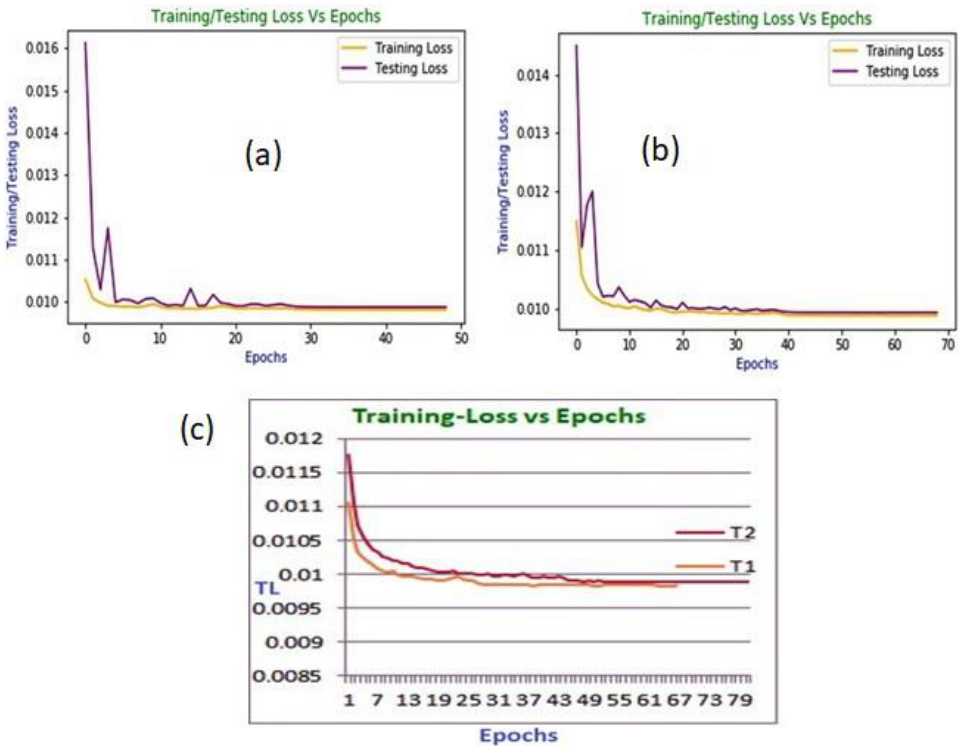
Figure 4. ( a ) The training and testing loss versus epoch curve in T3; ( b ) The training and testing loss versus epoch curve in T4; ( c ) The training loss versus epoch curves in T1 and T2. The training loss (TL) versus epoch curves for the proposed framework in T1 and T2 are demonstrated in Figure 4c, from which it is evident that the curves start to become stable after around 54 and 52 epochs in T1 and T2, respectively. Moreover, the training is halted at 49 and 69 epochs in T3 and T4, respectively, while the training is halted at 67 and 81 epochs in T1 and T2, respectively, as observed from Figure 4a–c. The pre-trained model performs training and testing (evaluation) on the transformed PVC beat images without experiencing any over-fitting. So, it attains the intended level of achievements on the MIT-BIH and INCART